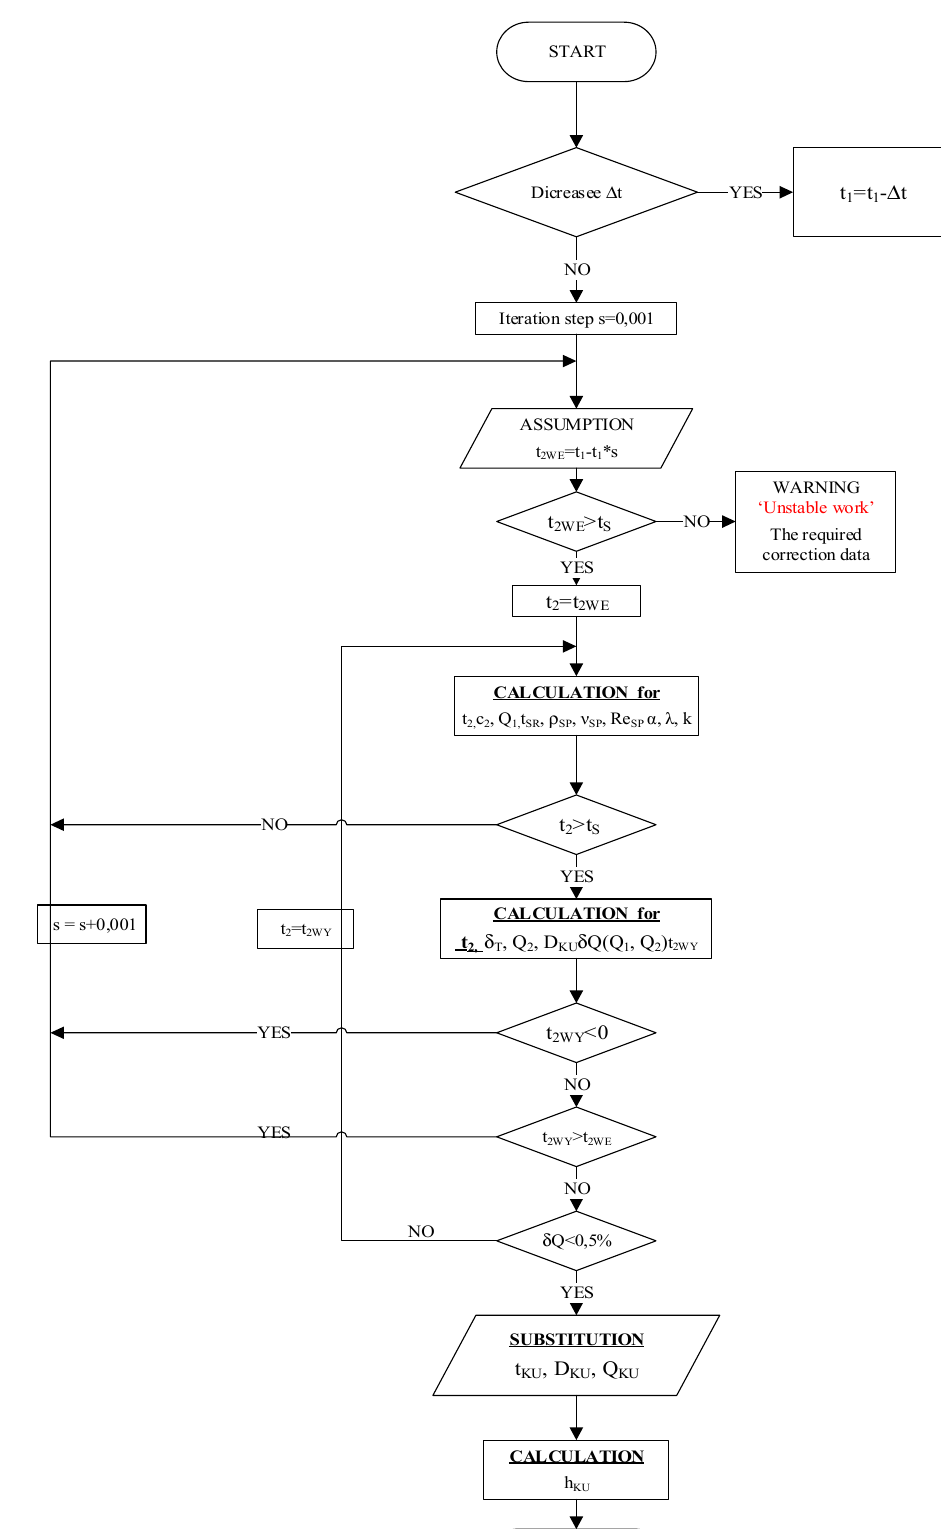
Figure 4. Calculation algorithm of boiler parameters.